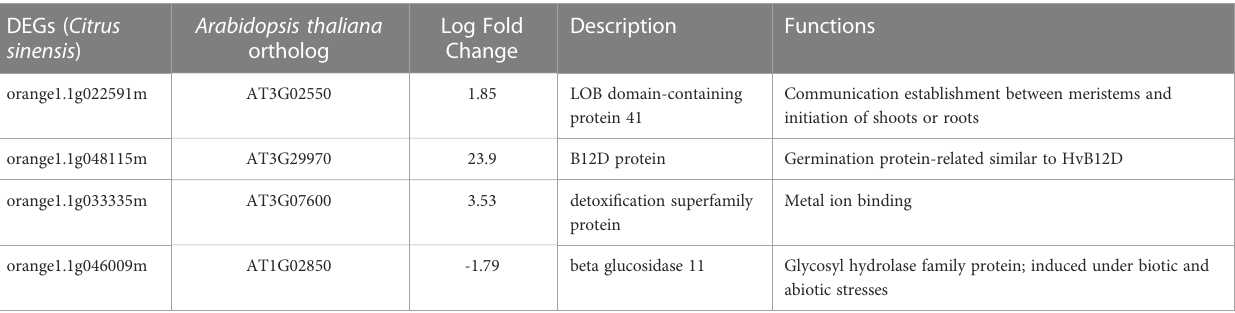
TABLE 1 Differentially expressed genes (DEGs) in buds of severely symptomatic Huanglongbing (HLB)-affected ‘ Hamlin ’ sweet orange trees compared to mildly symptomatic trees in November. DEGs ( Citrus sinensis